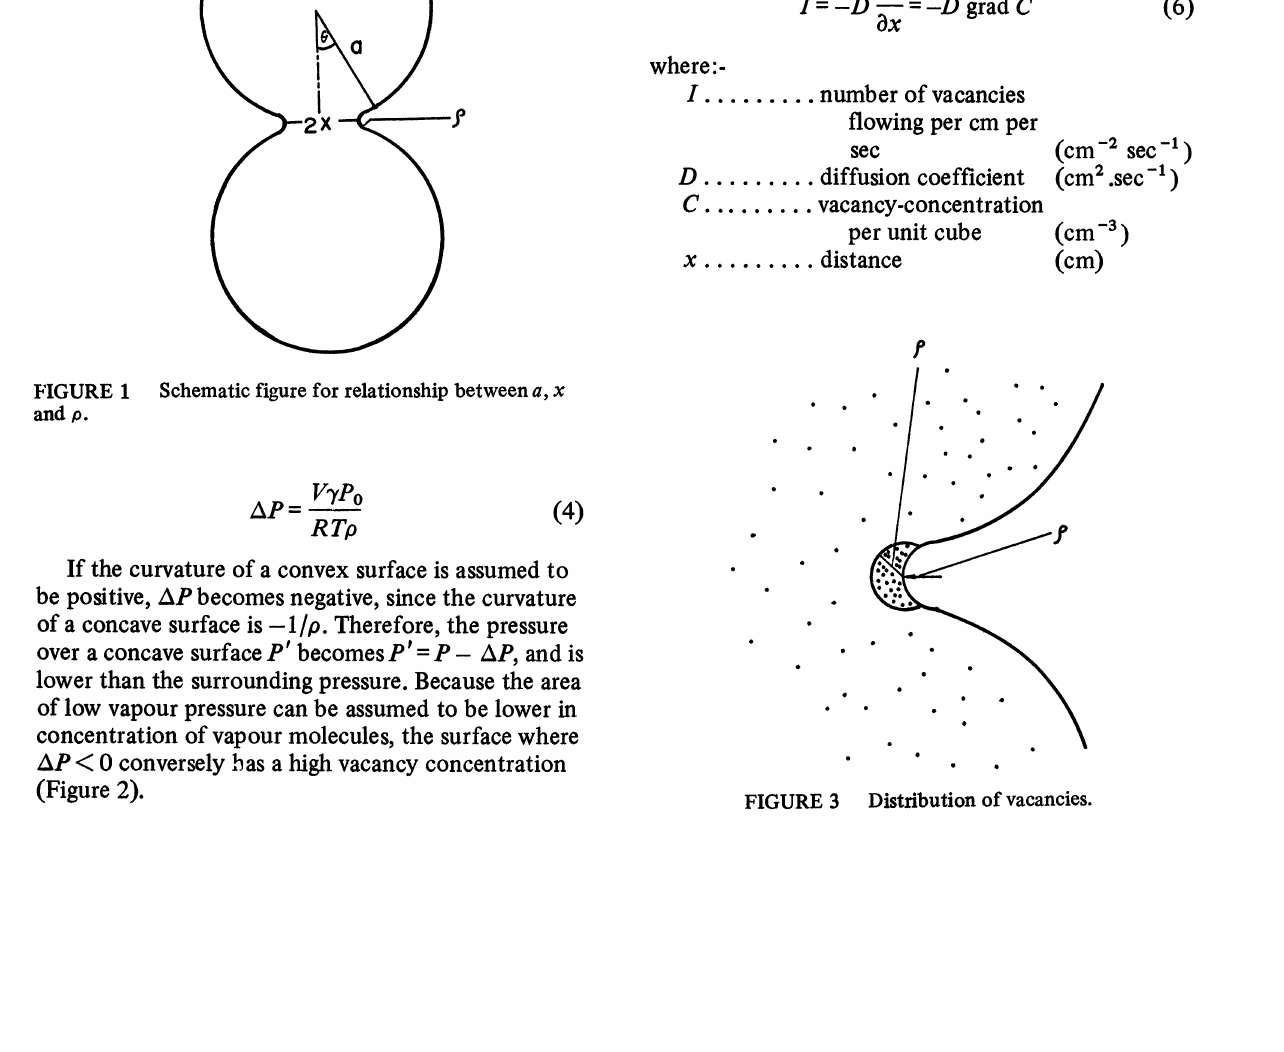
FIGURE 1 Schematic figure for relationship between a, x and p.